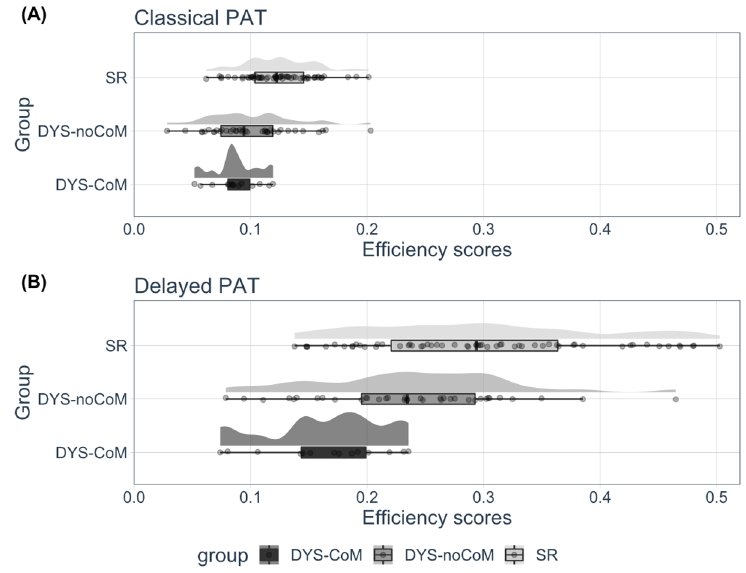
Figure 3. Descriptive raincloud plot of efficiency scores by group for ( A ) the Classical and ( B ) the Delayed PAT, with distribution of raw data, probability density, and summary statistics (i.e., boxplot with median, interquartile ranges, and confidence interval). SR: Skilled readers,